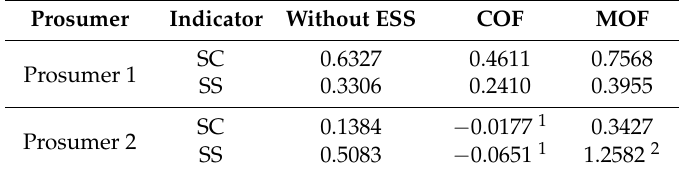
Table 1. SC and SS indicators for each of the prosumers with individual schedule. Prosumer